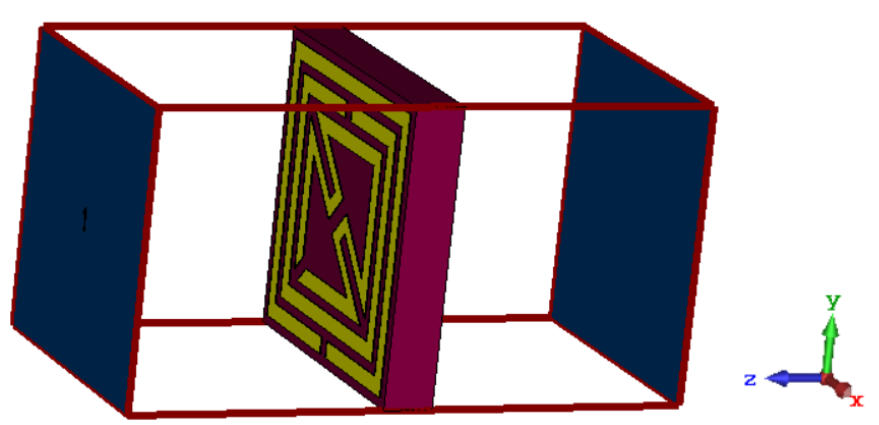
Figure 2. Boundary condition for the interaction of the applied electromagnetic signal. black arrow show the boundary condition of waveguide port excitation.